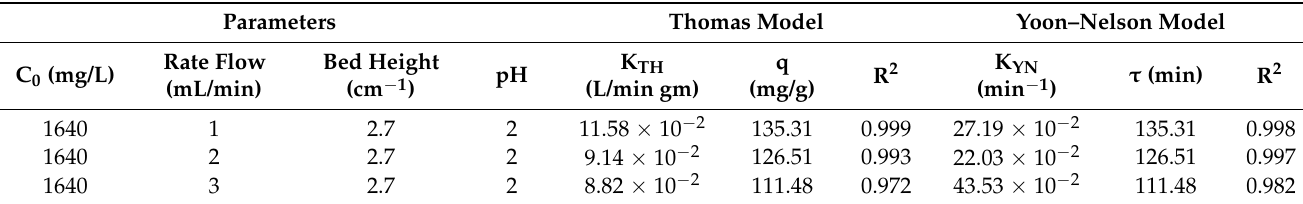
Table 7. Adsorption parameters calculated from the Thomas and Yoon–Nelson models.